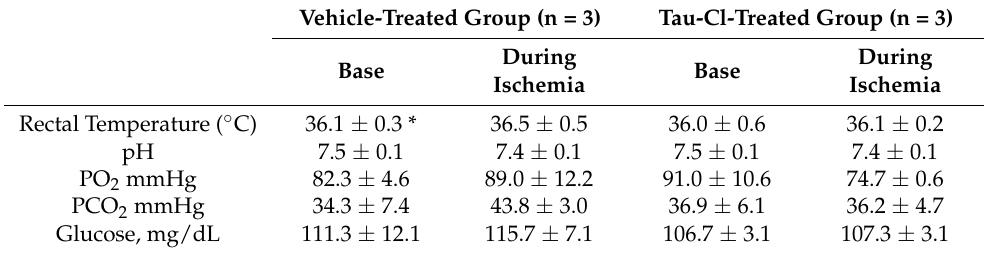
Table 1. Physiological